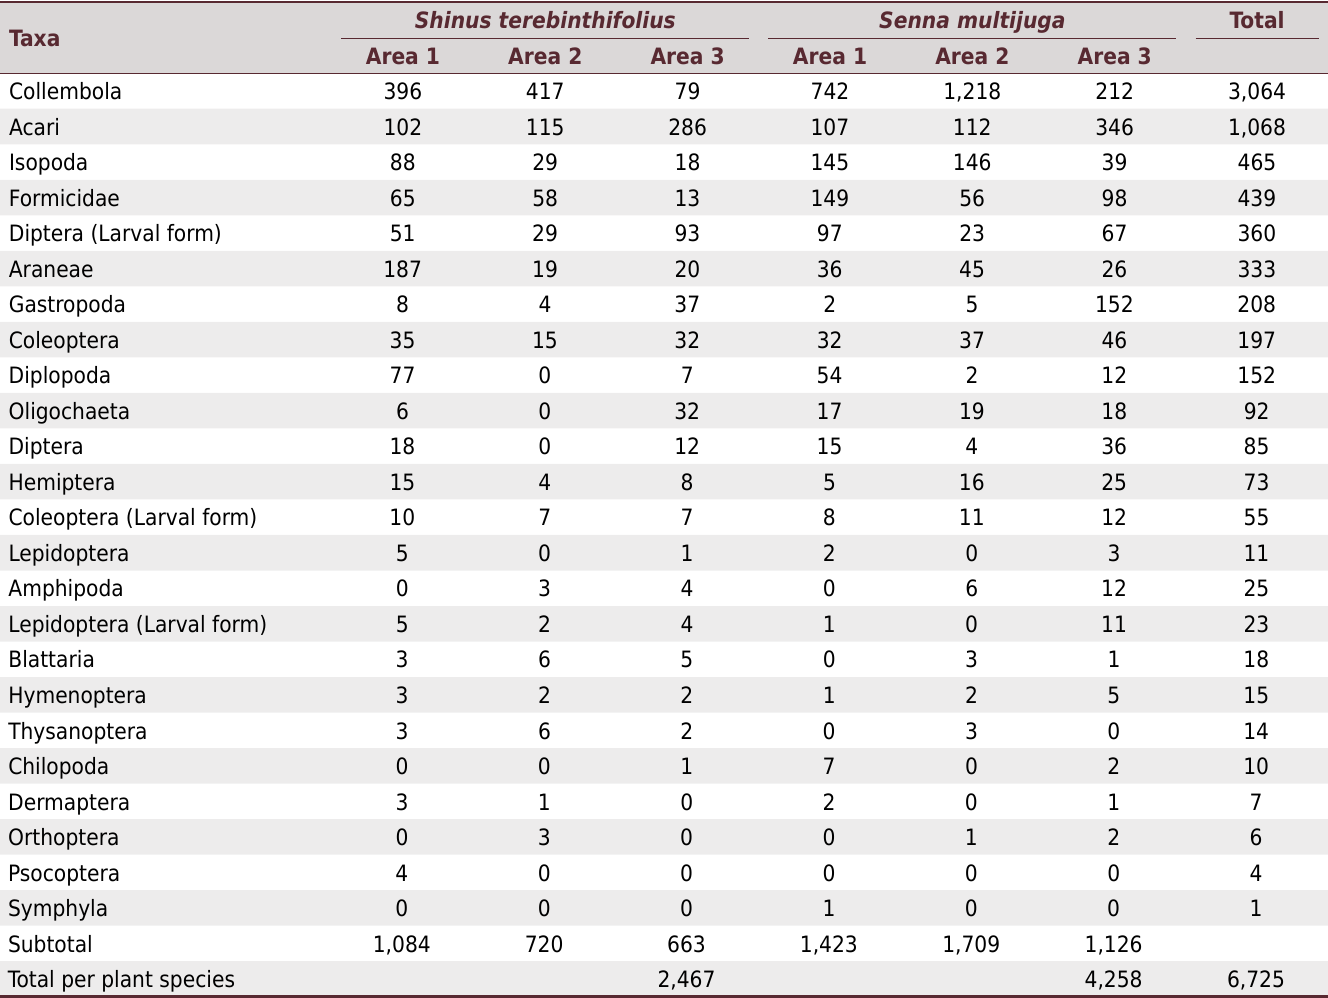
Table 3. Total abundance of groups of meso- and macroinvertebrates in descending order collected from litter bags of Schinus terebinthifolius and Senna multijuga for the three study areas. The juvenile forms were recorded individually only for cases in which it was possible to distinguish the form of resource